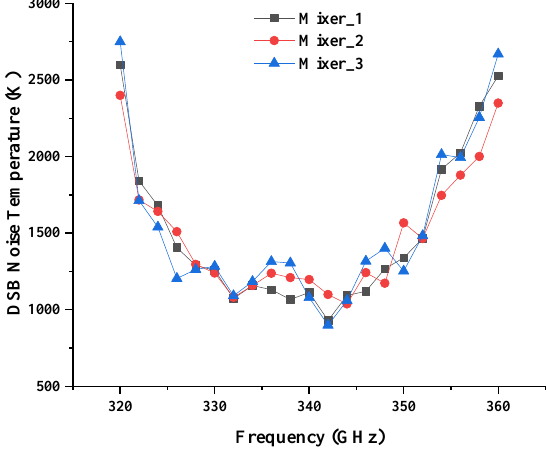
Figure 17. Comparison of the measured DSB noise temperature of three different mixer modules.